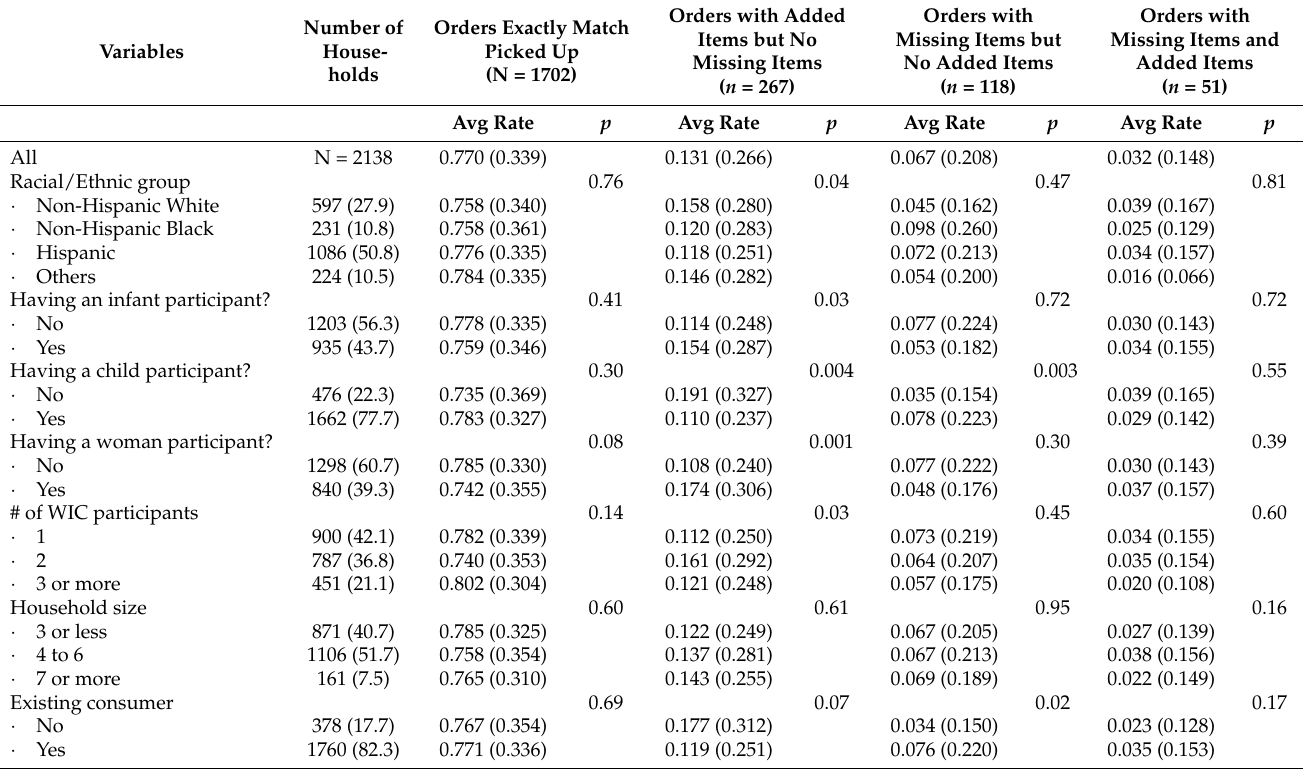
Table 2. Online orders characteristics across socio-demographics (# of orders =